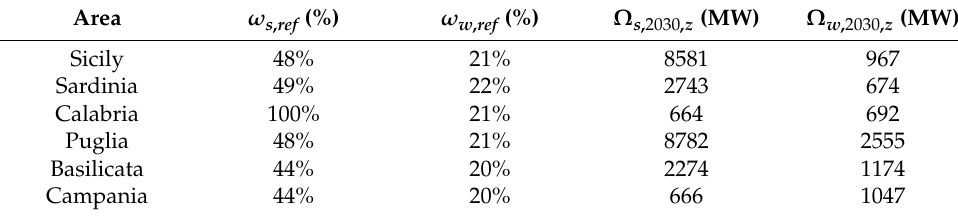
Figure 7. New RES generation distribution at national level in the NT CR scenario and variation compared to the original 2030 NT one. Regions of the same color belong to the same market zone of the Italian power system. Table 3. Rate of concretisation and target fixed for the solar and wind on-shore technologies’ increase values for all areas under study with the 2030 year horizon.